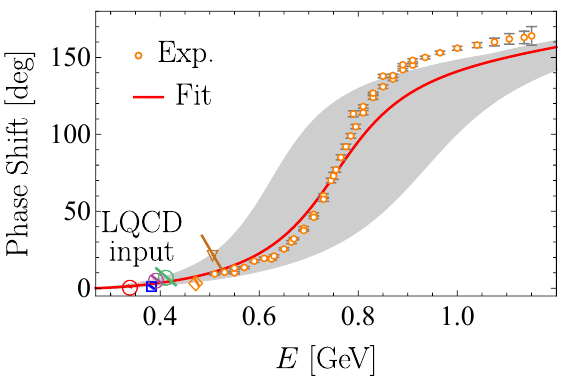
Figure 14 . P-wave ππ phase shifts extracted by matching the phenomenological model to the FV energy levels below the first inelastic channel computed in lattice QCD [68]. Experimental data are taken from refs. [69, 70]. The red line shows the central result of the fit with the shaded area representing the fit uncertainty. The six lattice QCD energy levels with uncertainties are shown by various open symbols using the same notation as in figure